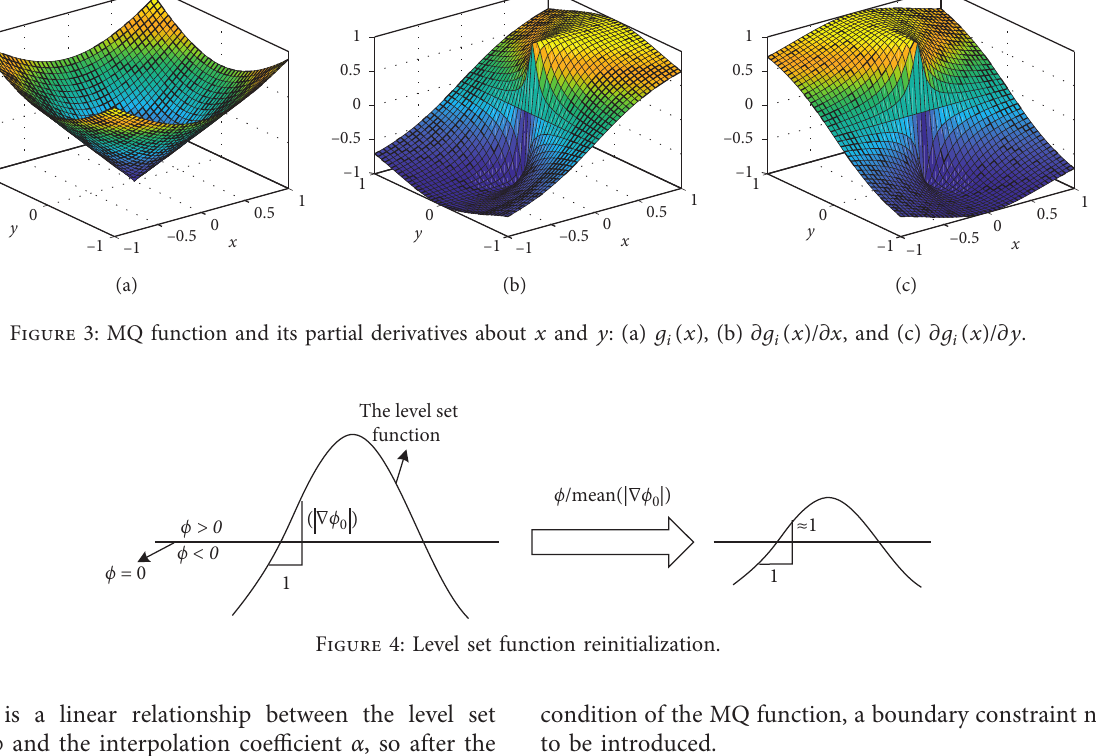
Figure 3: MQ function and its partial derivatives about x and y : (a) g